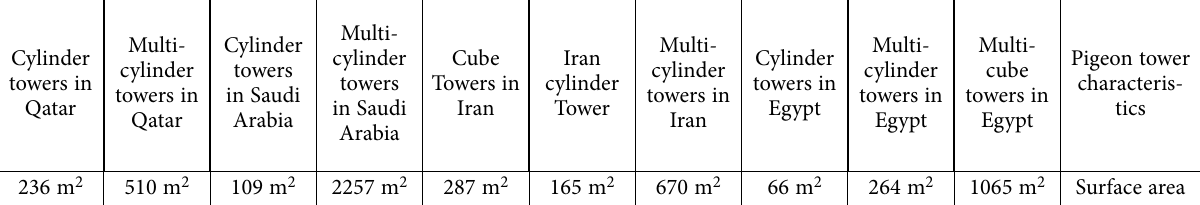
Pigeon tower characteris-